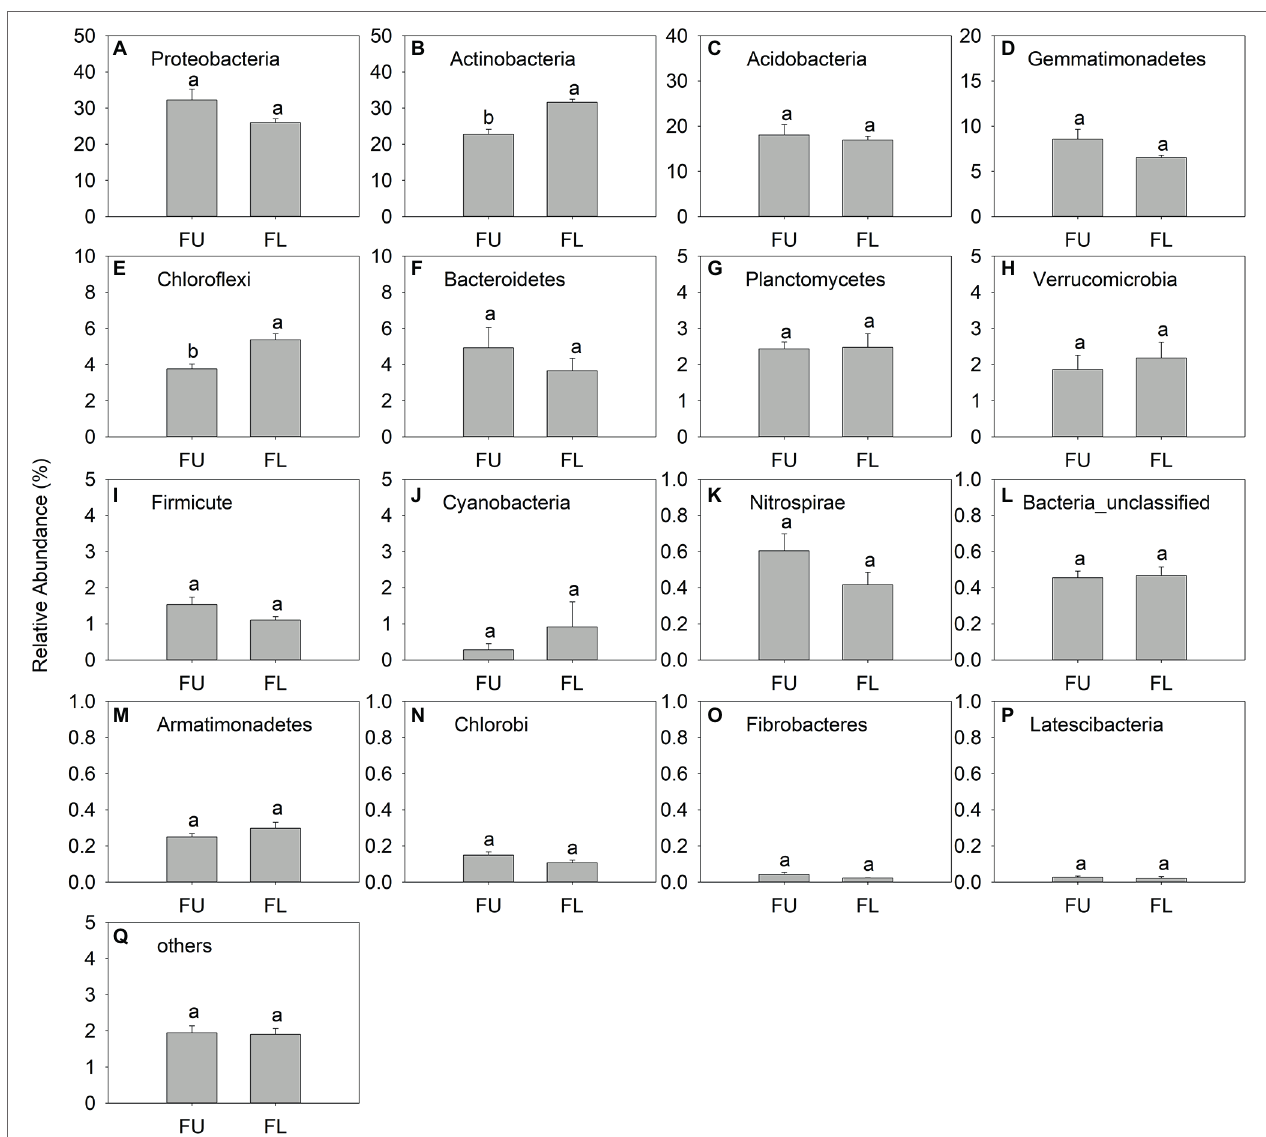
FIGURE 6 | Relative abundance (% of individual taxonomic group) of dominant bacteria phyla (mean ± SE, n = 4) in microbial communities following FU and FL of alfalfa. (A-Q) represented different soil bacterial at phylum level. Different lowercase capital letters indicate statistically significant difference among communities at p =